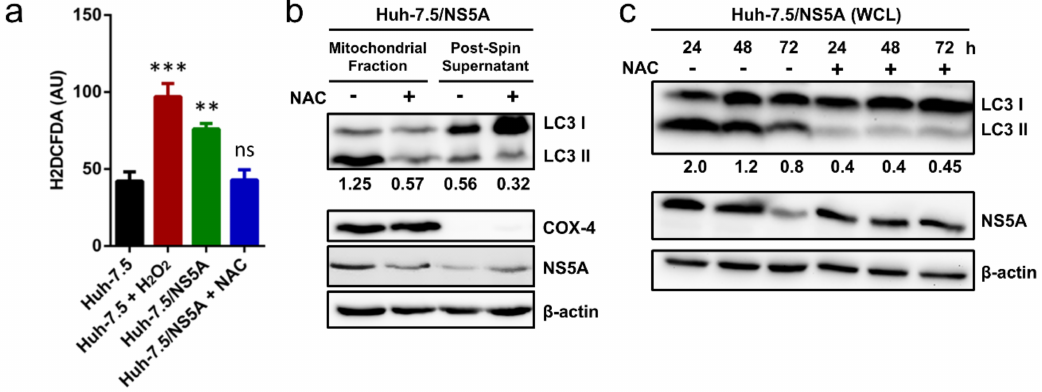
Figure 5. Inhibition of ROS Attenuates NS5A-Induced Auto/Mitophagy. ( a ) Huh-7.5 cells and Huh-7.5/NS5A were seeded in 6-well plates overnight followed by treatment of the Huh-7.5/NS5A cells with or without 20 mM NAC for 48 h. Subsequently, the cells were labelled with 20 µ M H 2 DCFDA for 30 min and immediately analyzed by flow cytometry. Huh-7.5 cells treated with 1 mM H 2 O 2 for 30 min served as positive control. The mean fluorescent intensity values ± SD are shown. ( b ) Huh-7.5/NS5A cells were seeded in 10 cm dishes and treated with or without 20 mM NAC for 48 h. Cells were harvested for isolation of the mitochondrial fractions and used to perform a Western blot for the indicated proteins. COX-4 served as mitochondrial marker. ( c ) Huh-7.5/NS5A cells were seeded in 6-well plates and treated with or without 20 mM NAC. The whole cell lysates (WCL) were harvested at the indicated time-points post-treatment and analyzed by Western blotting. Quantitative data and representative immunoblots are from 3 independent experiments. Numbers shown in the Western blot panels indicate the expression levels of LC3II relative to β -actin, which served as a loading control. Asterisks (*) denote statistical significance compared with mock: ** p < 0.01; *** p < 0.001; ns = not